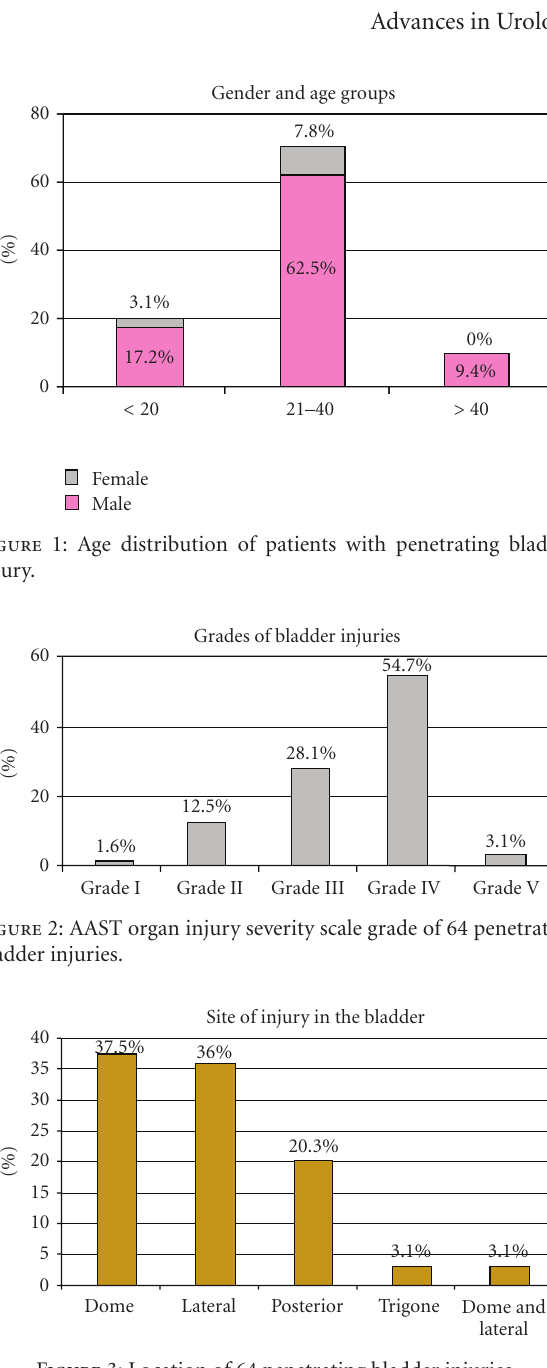
Figure 3: Location of 64 penetrating bladder